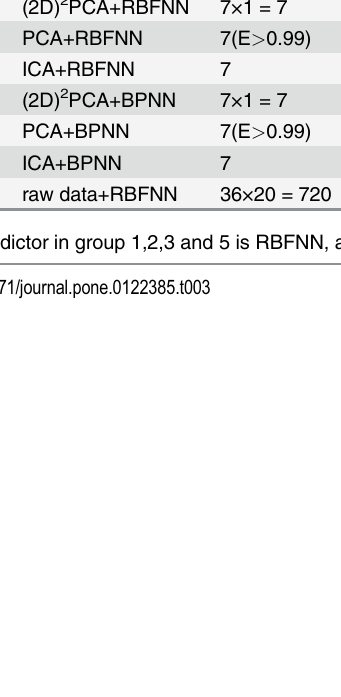
Table 4. The running time of ICA, PCA and (2D) 2 PCA associated with RBFNN and BPNN under different dimension. Group